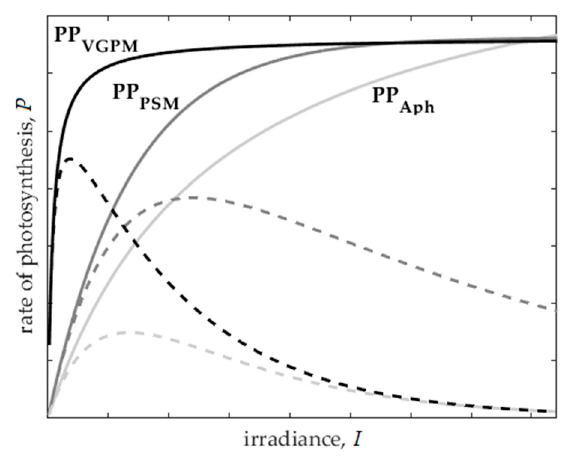
Figure 2. Photosynthesis-irradiance functions of the models used in the study: Solid lines—without photoinhibition, dotted lines—with photoinhibition.